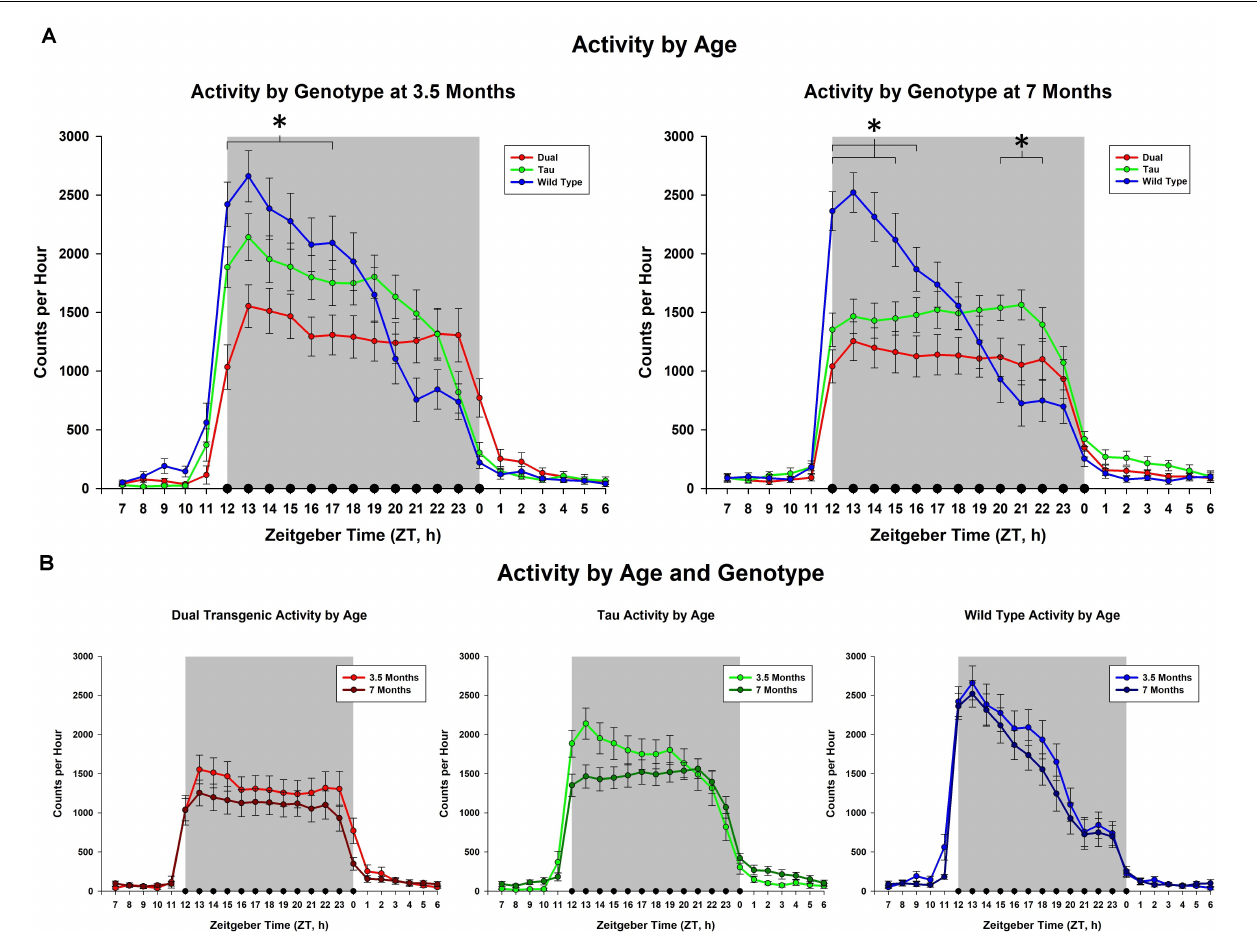
FIGURE 1 | Comparison of dark cycle activity by (A) Genotype by age and (B) age by genotype. Wildtype animals showed significantly higher total dark cycle activity than dual Tg animals at 7 months; hourly differences showed dual Tg animals were significantly less active than wildtypes early in the dark cycle, ZT12-17 at 3.5 months and ZT12-16 at 7 months. At 7 months tau animals were significantly less active than WT mice early in the dark cycle, ZT12-15, and significantly more active than WT mice later, ZT21-23 ( ∗ p <